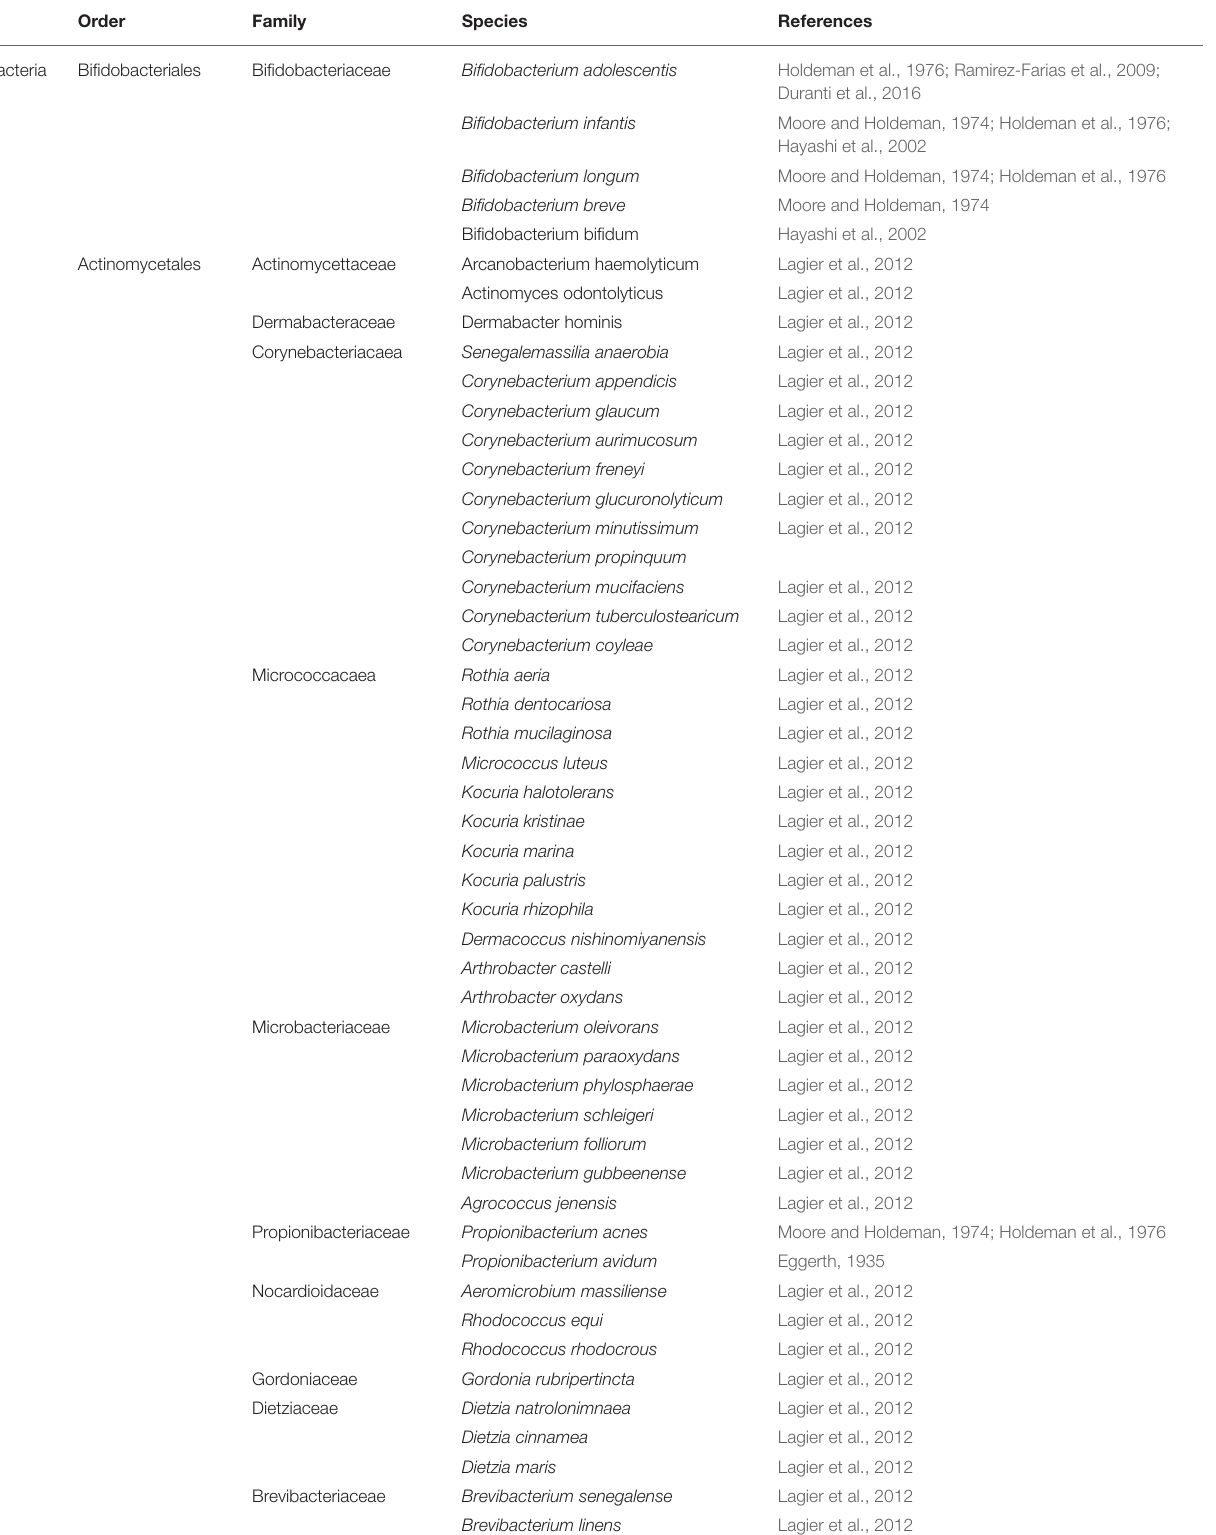
TABLE 3 | Actinobacteria phylum (class, order, family) and major species constituting the microbiota in healthy human gut.